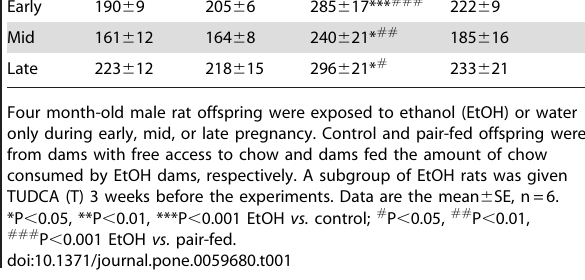
Control Pair-fed EtOH Glucose curve